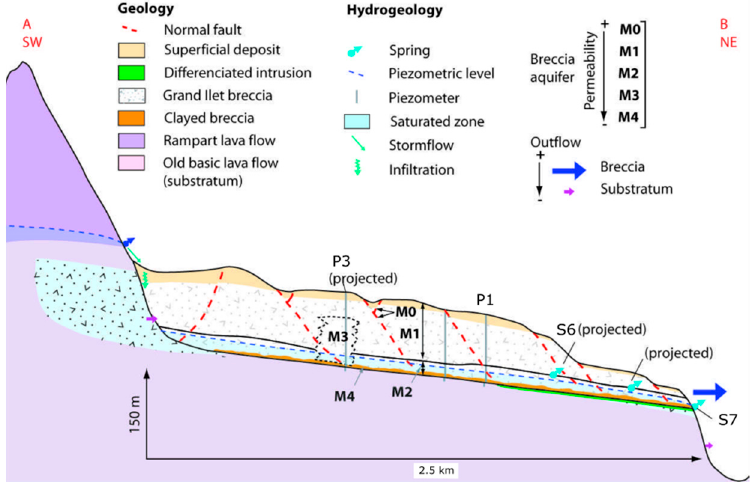
Figure 5. Schematic geological and hydrogeological section through the Grand Ilet area. Cross-section localized on Figure 4. M0–M4 correspond to the different permeabilities of the breccia aquifer. The unconsolidated Grand Ilet breccia contains an unconfined aquifer. Each ravine cutting into